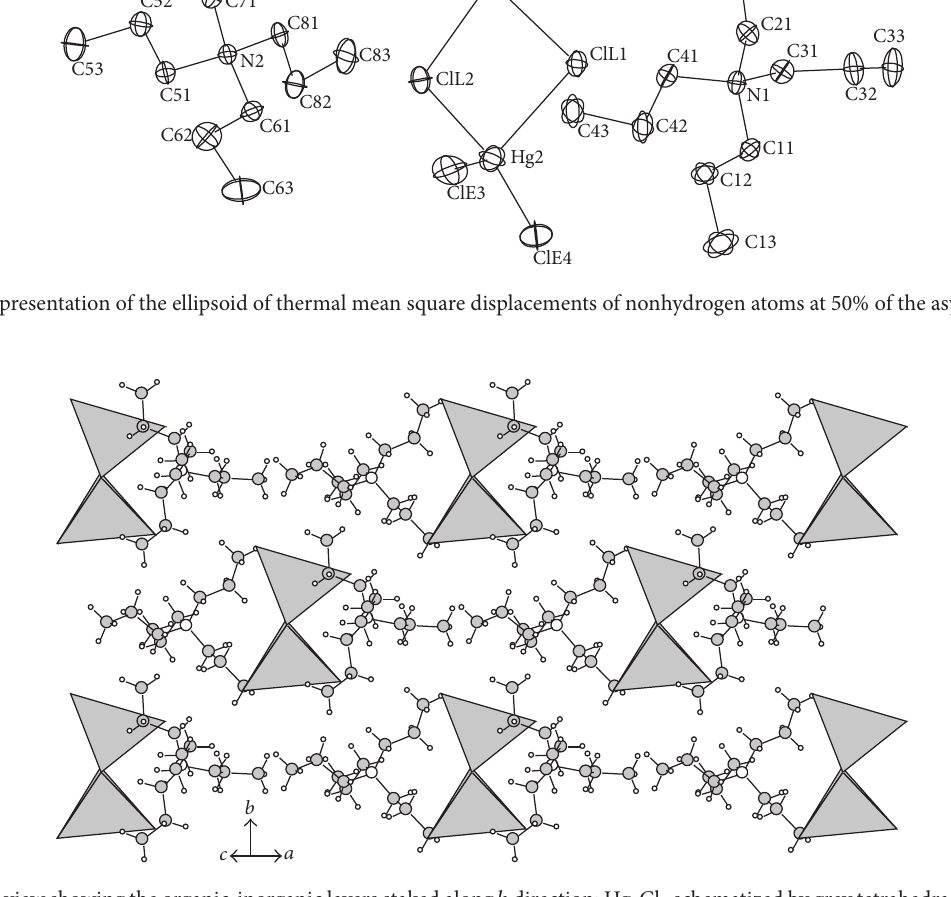
direction; Hg Cl schematized by grey tetrahedra, grate empty, and 2 6 𝑏𝑏